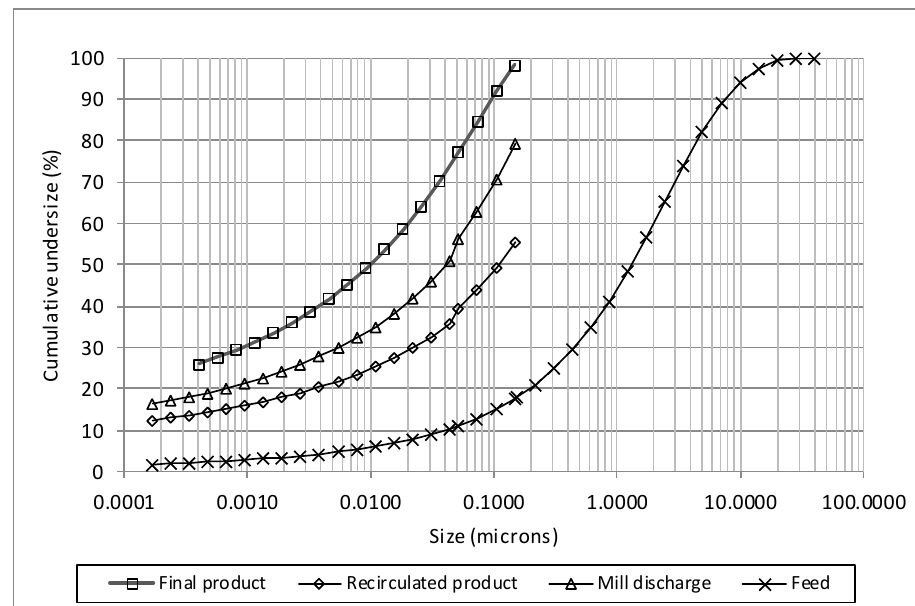
Figure 9. Simulation of the particle size distribution for products in the grinding circuit.